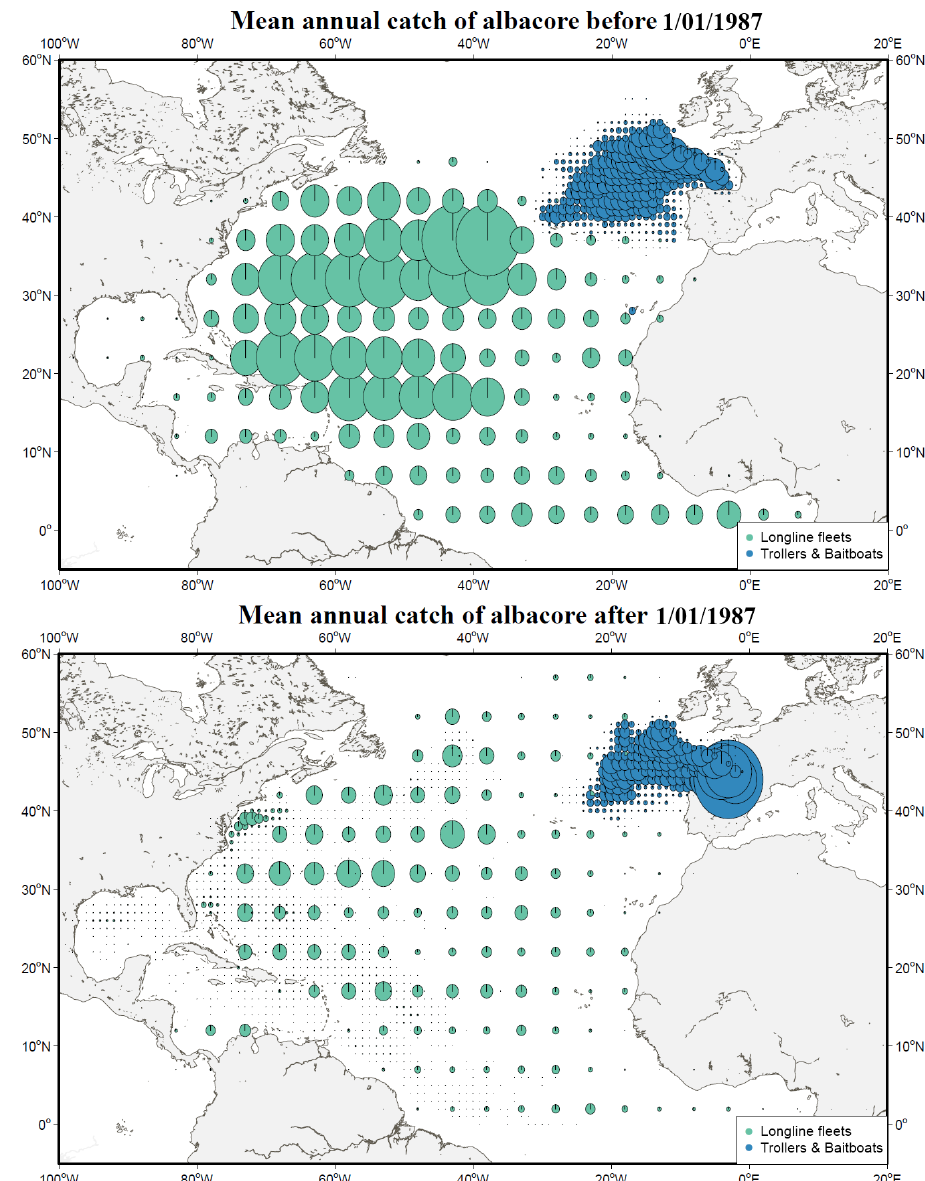
Figure 2. Spatial distribution of mean annual catch of North Atlantic albacore by longline (green) and surface (blue) fishing gears during the periods 1960–1986 and 1987–2008. The circles are proportional to the catch, with the same scale for both panels.